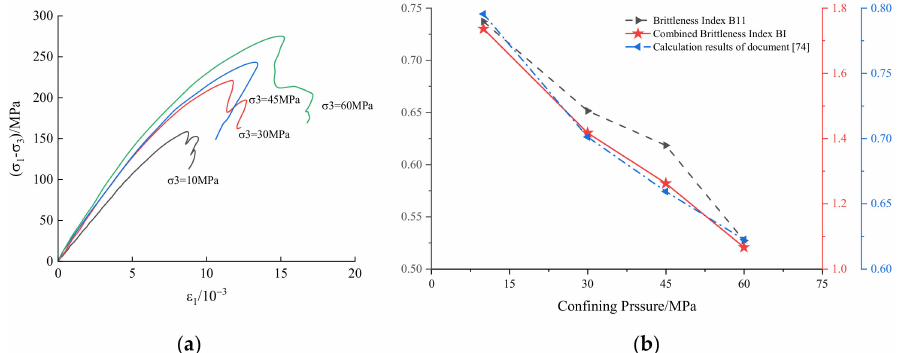
Figure 9. Calculation results of shale stress–strain curve ( a ) and brittleness index with incomplete post-peak curve ( b